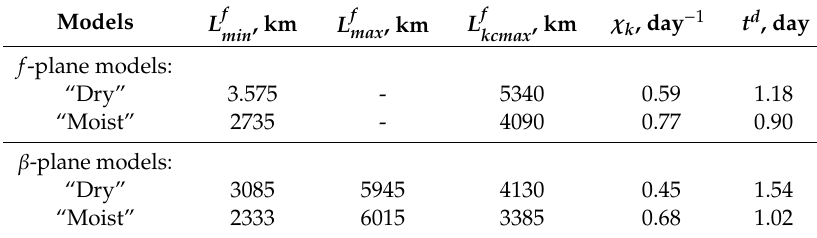
Table 1. Characteristics of baroclinic instability obtained from the f -plane and β -plane